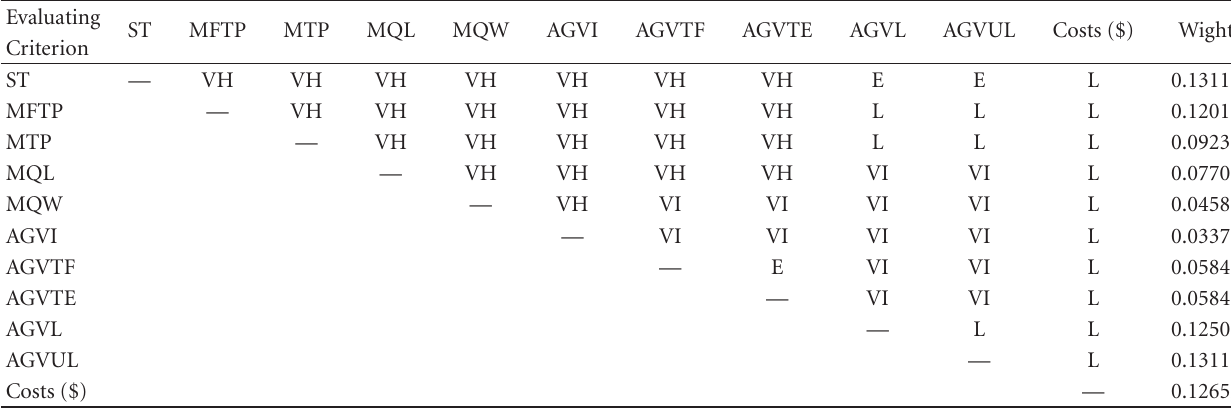
Table 9: Criteria comparison matrix.